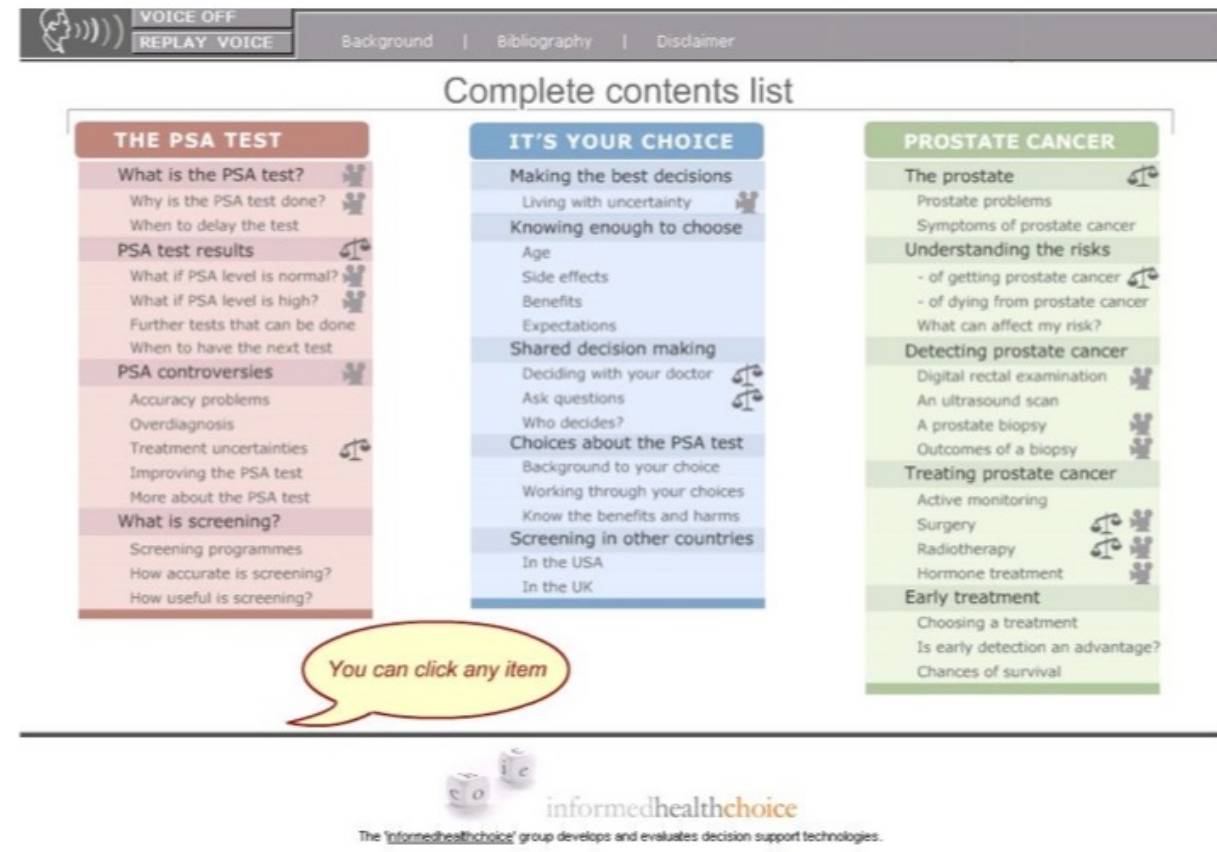
Figure 1. A screenshot of the Prosdex main contents